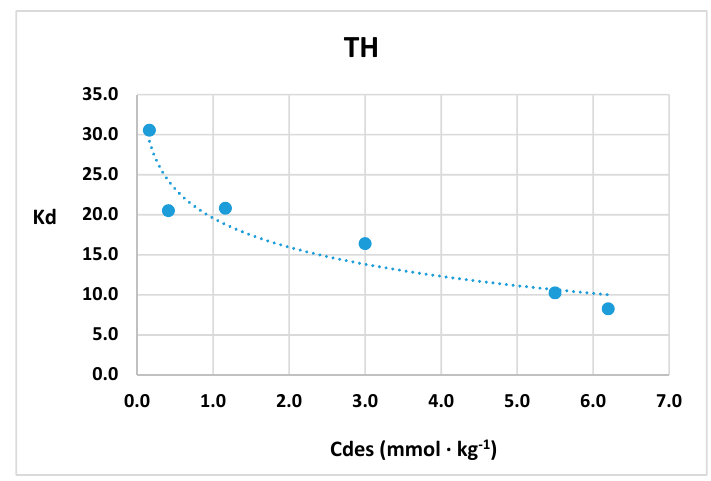
Figure 7. Trend of Kd vs. concentration of tungsten desorbed Cdes.